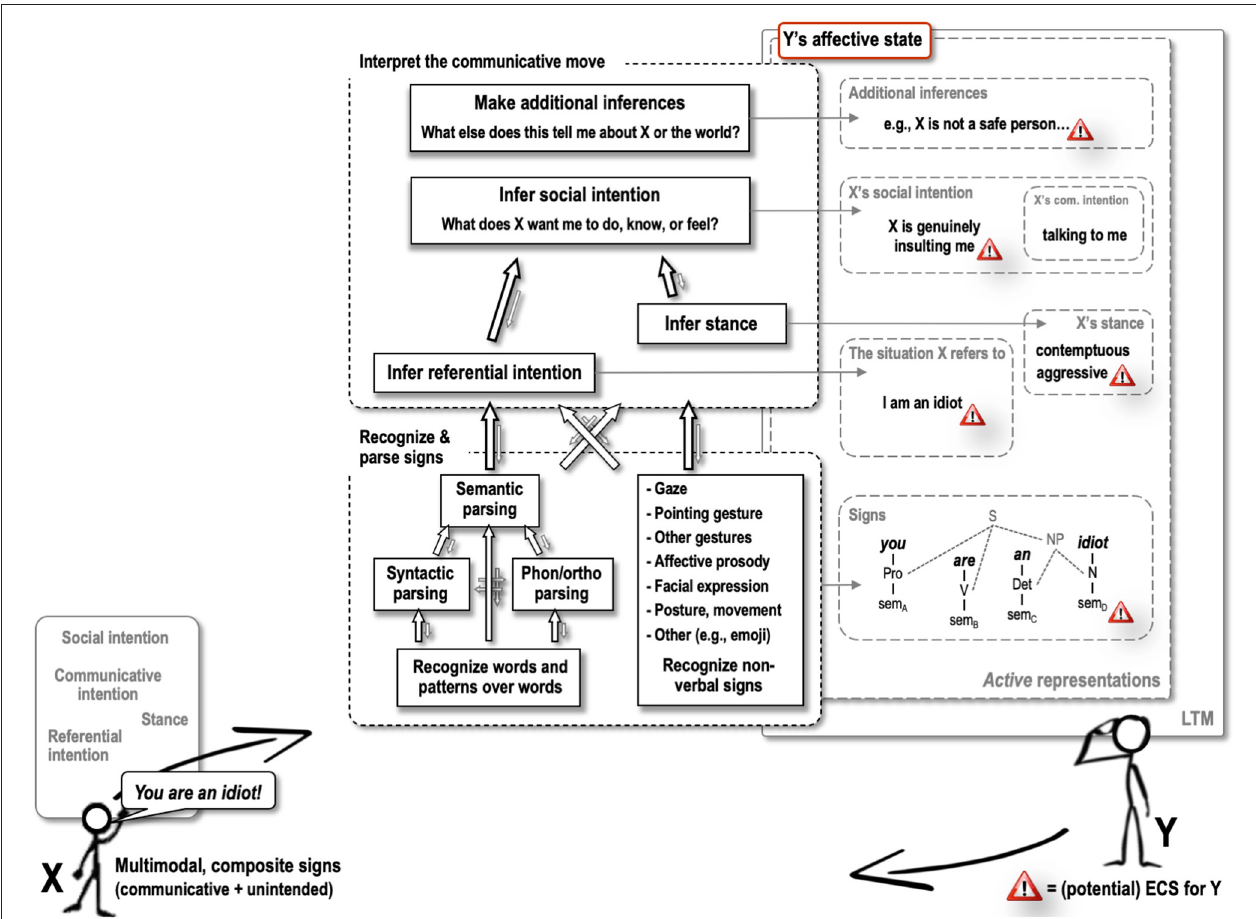
FIGURE 1 | The Affective Language Comprehension (ALC) model illustrated with an insult example. ECS, emotionally competent stimulus; LTM, long-term memory; Phon/ortho parsing, phonological or orthographic parsing; X’s com. intention, X’s communicative intention. See text and Van Berkum (2018, 2019) for